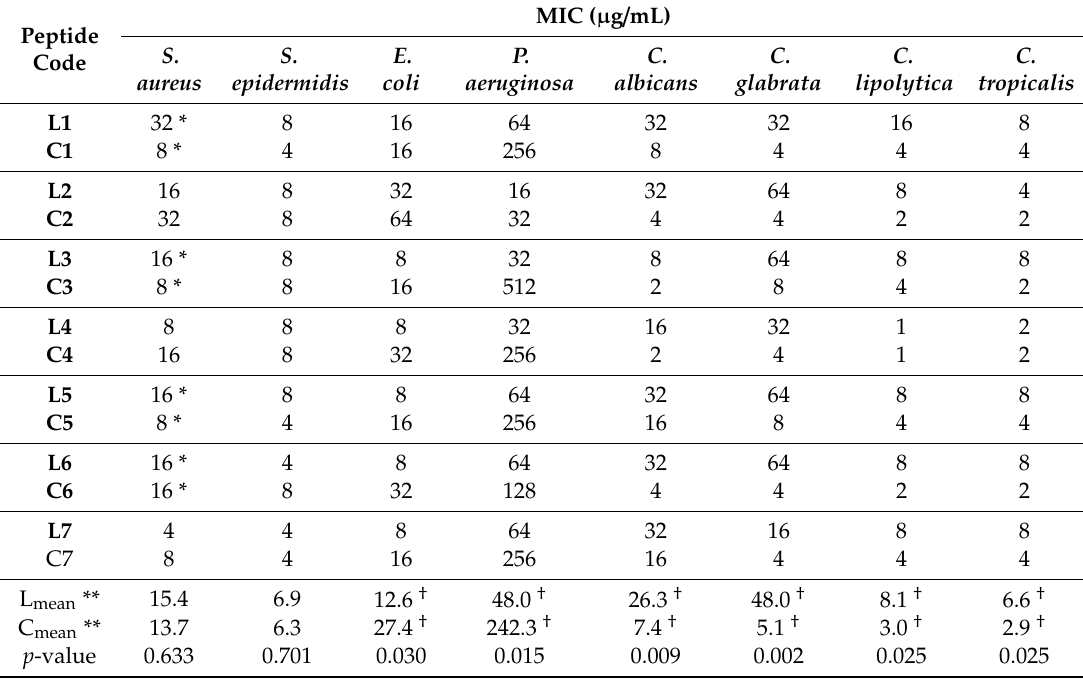
Table 2. Antimicrobial activity of